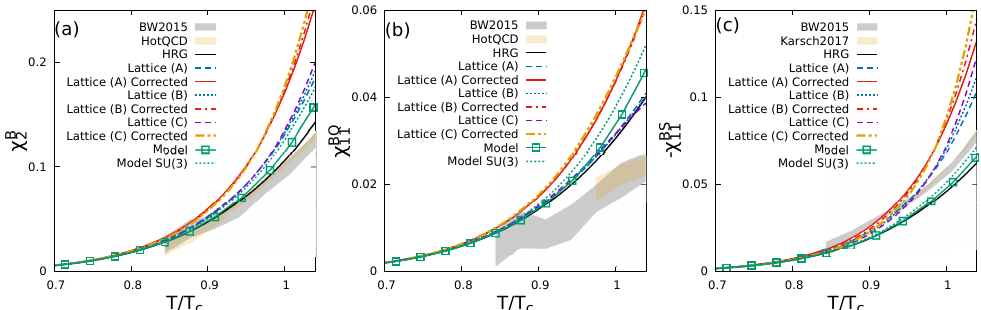
Figure 3. Fluctuations and correlations from the HRG model with and without the mass shifts: ( a ) baryon number susceptibility; ( b ) baryon–charge correlation; and ( c ) baryon–strangeness correlation are shown